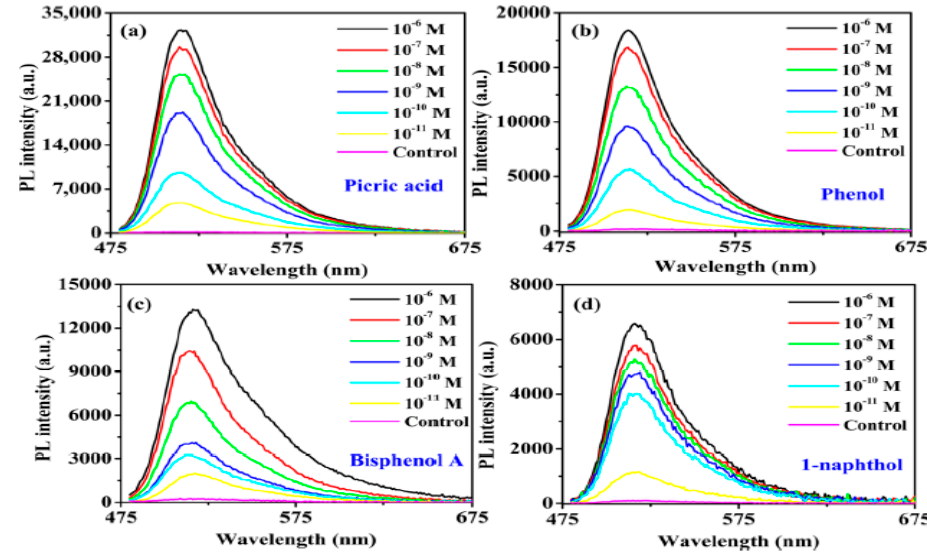
Figure 6. “Turn-On” fluorescence response of four different organic pollutants; picric acid ( a ), phenol ( b ), bisphenol A ( c ) and 1-napthol ( d ) toward a RGPD-fl composite probe [67].